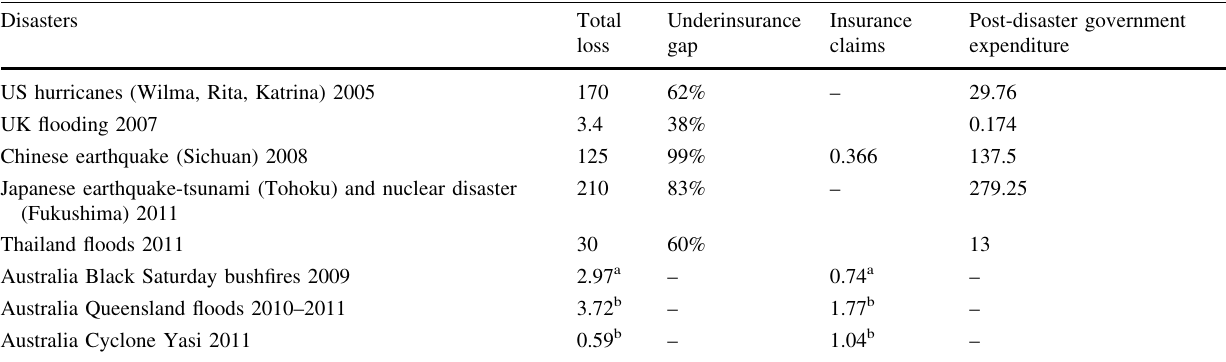
Table 1 Financial breakdown of select disaster events in billion US dollars